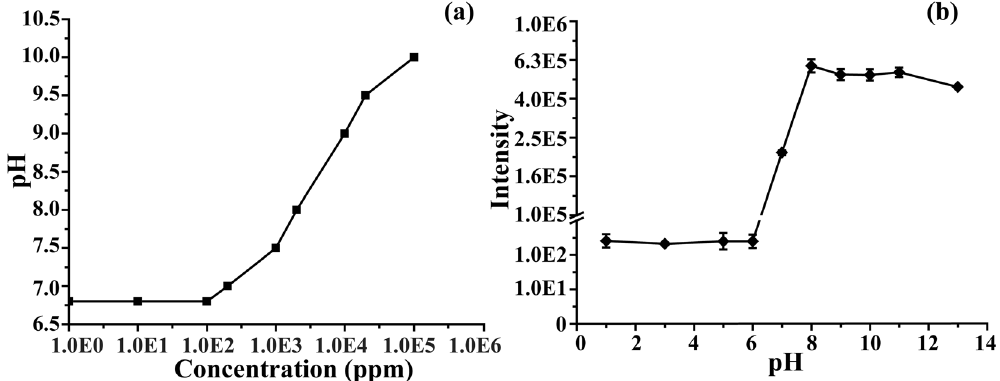
Figure 5. The pH value of 1-pyrroline solution in water as a function of concentration ( a ), and the signal intensity of 1-pyrroline vapor above the 200 ppb aqueous solution measured as a function of solution pH value ( b